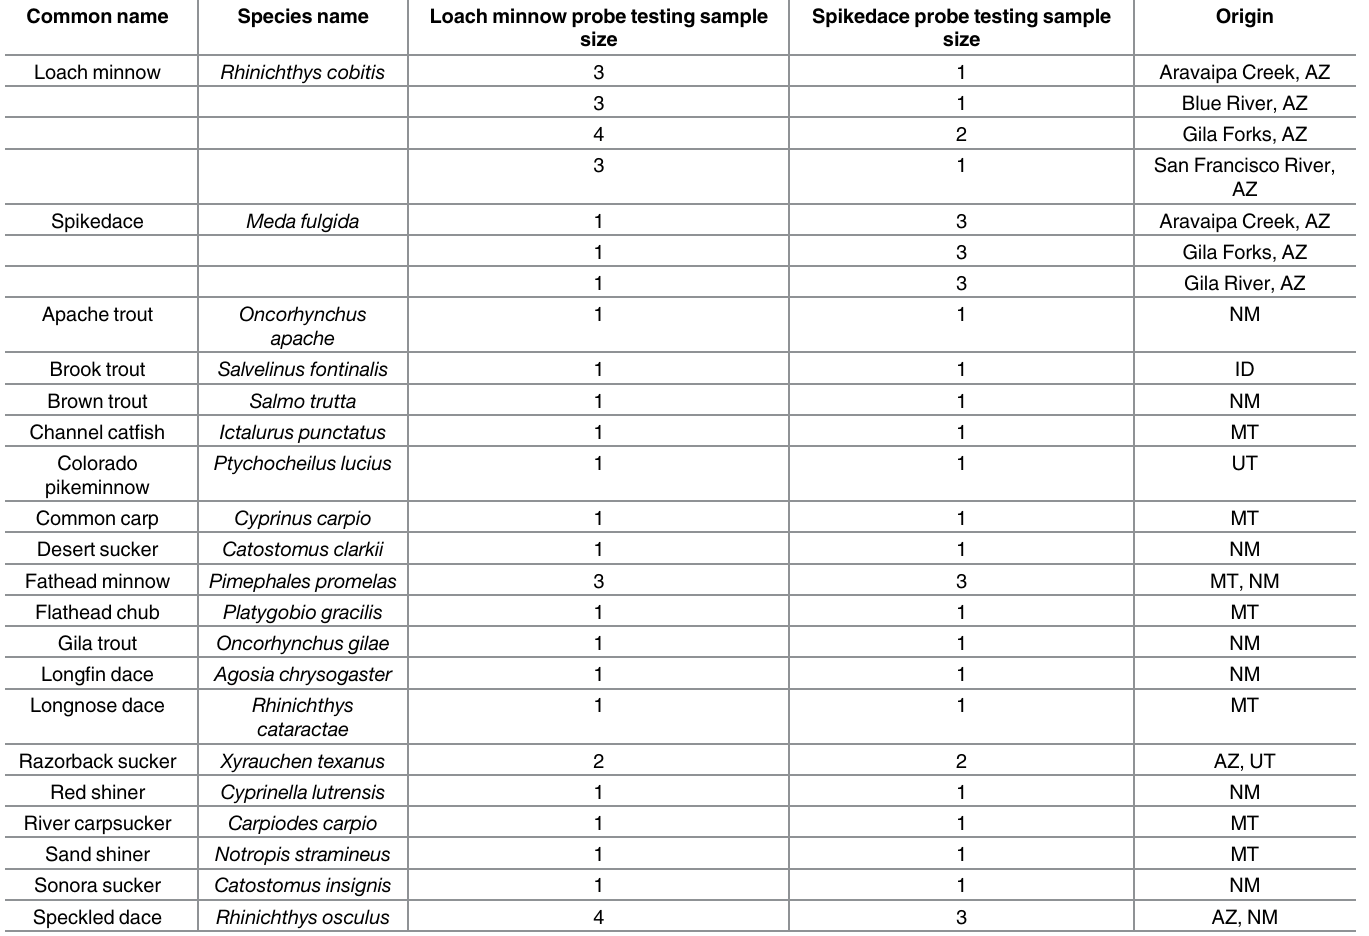
Table 3. List of species used for in vitro screening of the primers and probe. Origin refers to the waterbody for loach minnow and spikedace samples. For all other samples, origin is listed as